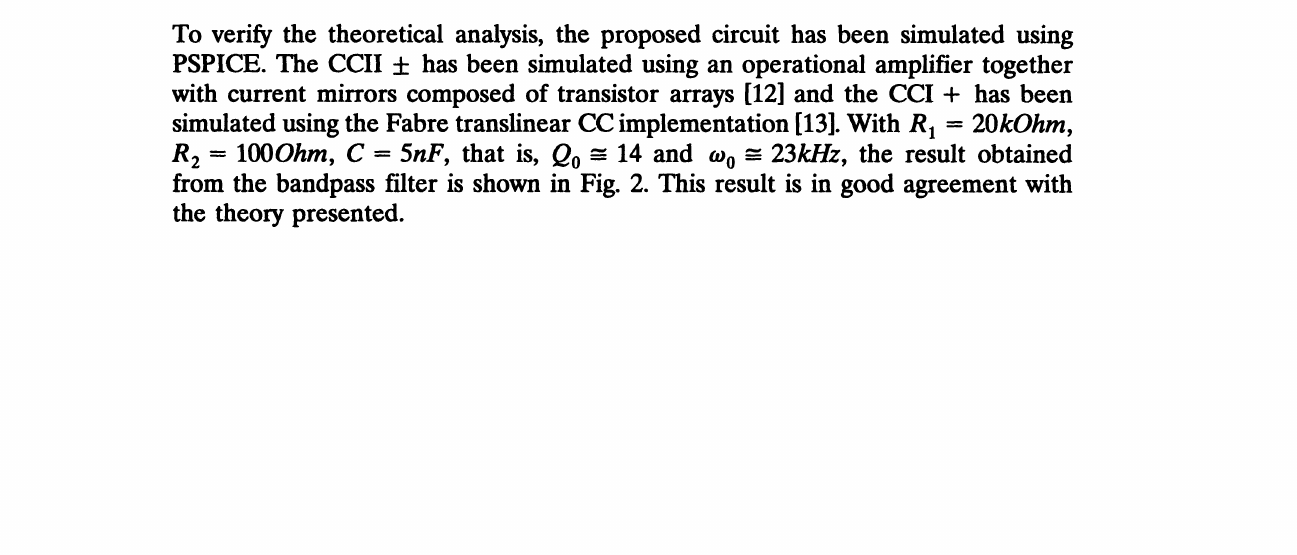
FIGURE 1 Proposed structure for realizing current-mode lowpass, highpass, bandpass, notch and allpass filters. All current conveyors are CCII + except current-conveyor # 1 is CCI + and current- conveyor # 3 is